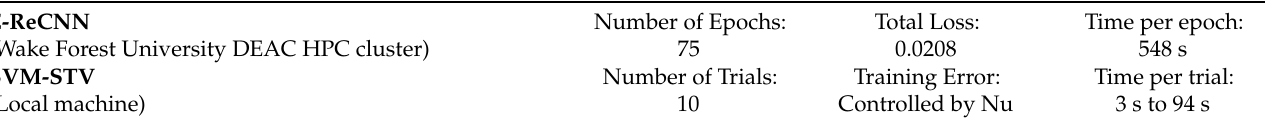
Table A3. Calculated costs of model training.